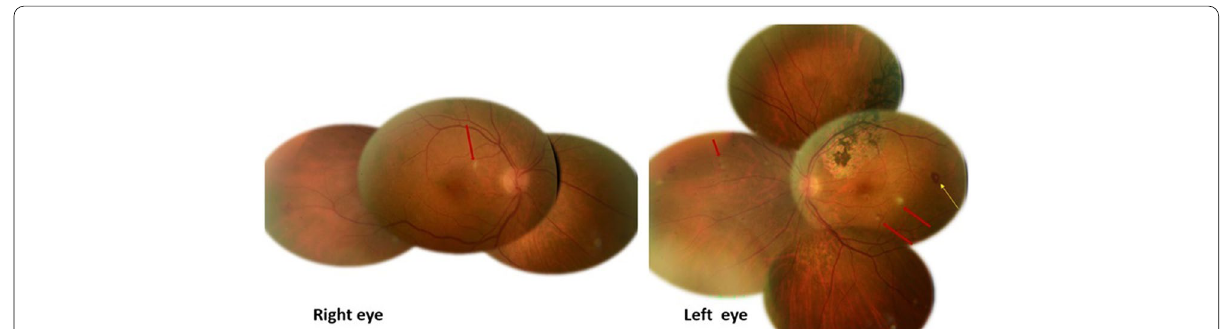
Fig. 1 Baseline composite fundus photography shows bilateral small yellow-white retinal lesions in the posterior pole and the periphery (red arrows), with a few retinal hemorrhages, some of which are white-centered (yellow arrow). Note the presence of an old, flat, well-delineated atrophic and pigmented lesion along the superotemporal retinal vascular arcade in the left eye